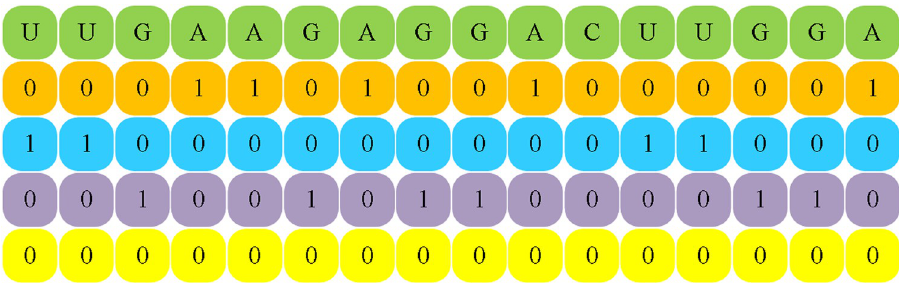
Fig 7. Four-bit one-hot encoding of the RNA